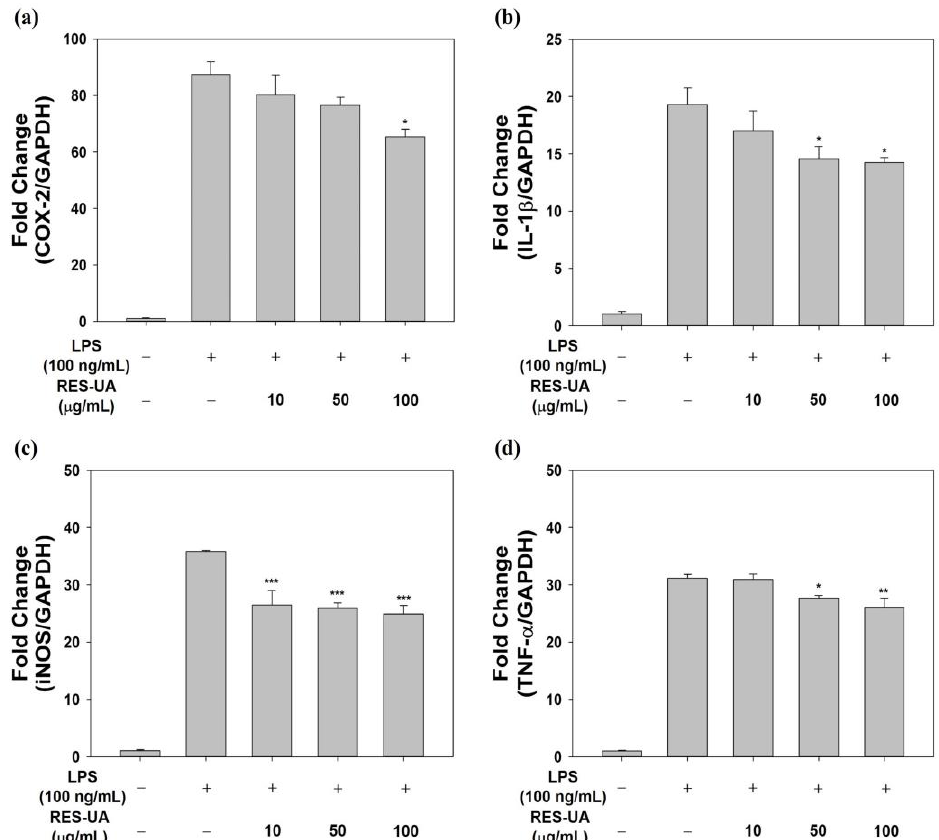
Figure 6. In vitro anti-inflammatory effects of RES-UA NPs in LPS-stimulated RAW 264.7 cells. The expression of mRNA for pro-inflammatory components was assessed using real-time PCR. ( a ) COX-2, ( b ) IL-1 β , ( c ) iNOS, and ( d ) TNF- α expression in LPS-stimulated RAW 264.7 cells after incubation with various concentrations of RES-UA NPs. p values are for comparisons between RES-UA NPs and LPS-stimulated cells. Values are represented as means ± SD. * p < 0.05; ** p < 0.001; *** p < 0.0001; n = 4 per group.